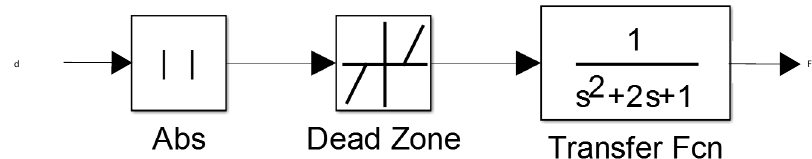
Figure 4. Computation of the residual signal, r ( t ) . Note that the Simulink (cid:114) dead zone block is used (start of dead zone value equal to zero and end of dead zone value equal to 2000).